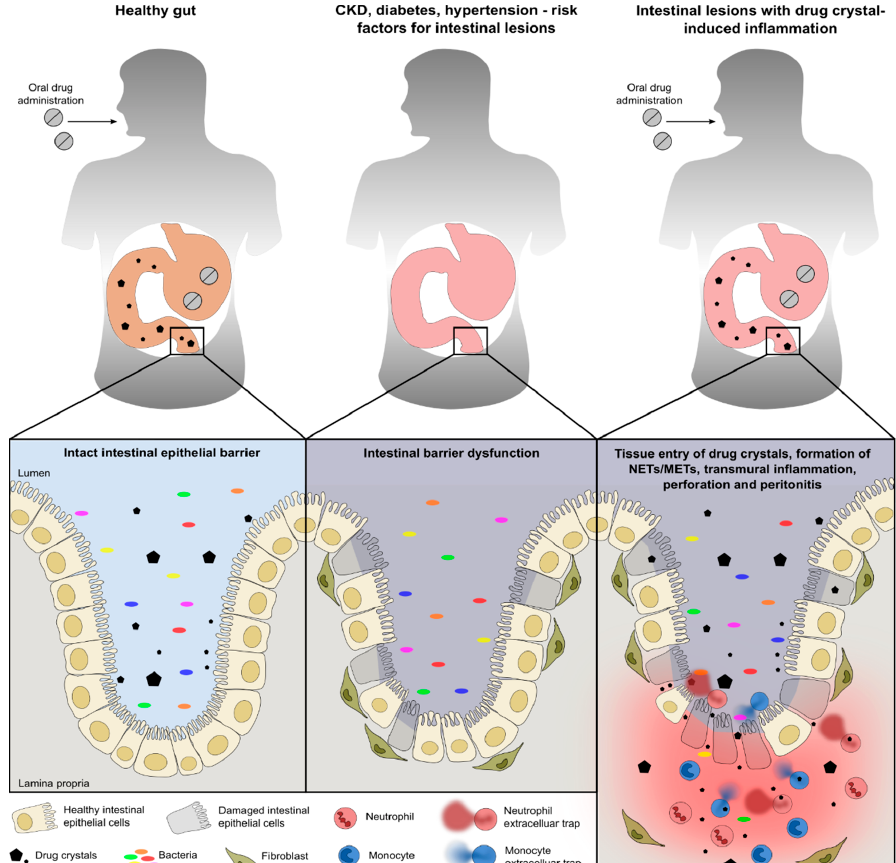
Figure 8. Schematic illustrating the pathogenesis of the intestinal epithelium during health and disease. Under healthy conditions, intestinal epithelial cells form a physical barrier that maintains segregation between the lumen and lamina propria / mucosa even after the intake of drugs (left panel). Chronic diseases such as hypertension, chronic kidney disease (CKD), diabetes, etc., can contribute to intestinal barrier dysfunction associated with intestinal epithelial cell death, leakage, fibrosis, and impaired epithelium regeneration (middle panel). This predisposes patients, in relation to the intake of drugs such as sevelamer, polystyrene sulfonate, and cholestyramine, to gastrointestinal injury and inflammation. Under certain conditions, drugs that are not completely digested and remain as crystalline particles in the intestine may further aggravate the intestinal barrier dysfunction that is associated with cell death, inflammation, fibrosis, and neutrophil and monocyte extracellular trap (NETs and METs) formation (right panel).